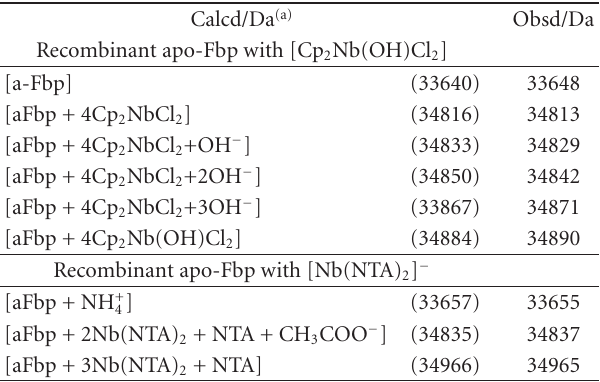
Table 2: Species detected by ESI-MS assay of products from